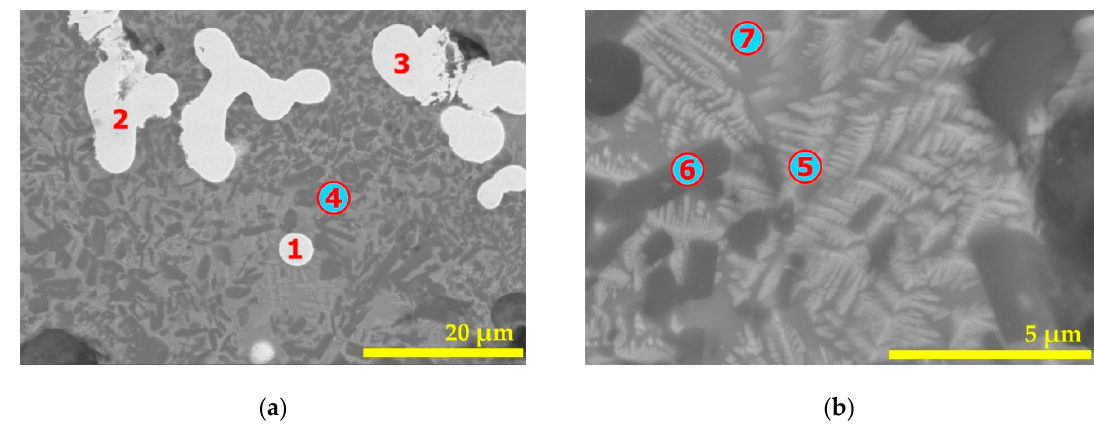
Figure 15. SEM micrographs (BSE image) of the (hematite + W–PVC + clay) sample treated at 1025 °C for 2 h: ( a ) general view of the obtained residue and ( b ) greater magnification in an area having a complex composition. The numbers 1 to 7 indicate the locations of microanalysis. Table 3. Elemental composition (EDS data) of the (hematite + W-PVC + clay) sample treated at 1025 °C for 2 h. Elements Spot n ◦ 1,2,3